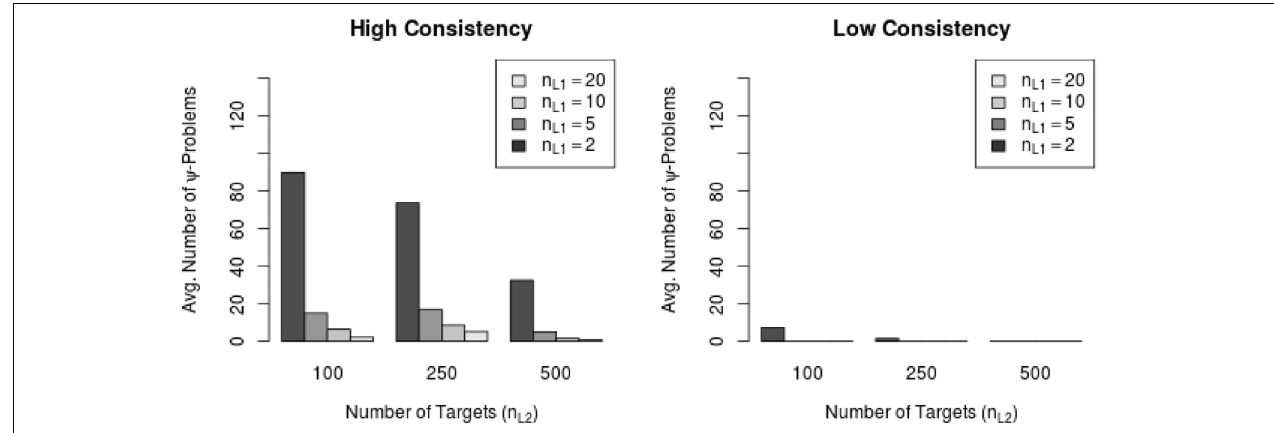
FIGURE 5 | Average number of (cid:4) -warning messages in high and low consistency conditions. n L 1 = number of Level 1 units; n L 2 = number of Level 2 units.